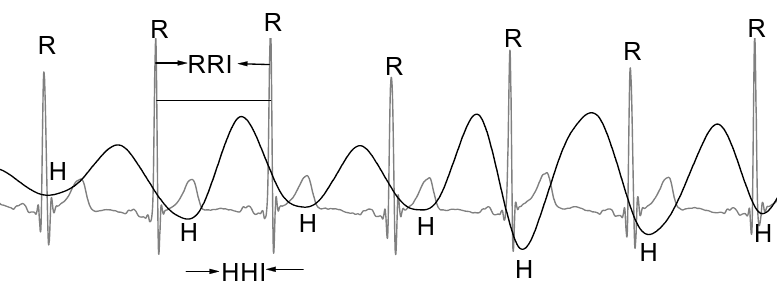
Figure 2. Waveforms of ECG and heartbeat.